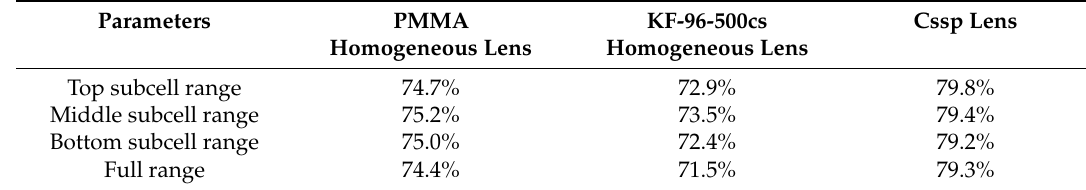
Figure 11. Simulated optical efficiency for varied focal lengths in comparison with different wavelength bandwidths corresponding to the top (blue), middle (green), bottom (red) subcell of the triple-junction solar cell, and the full solar spectrum at C = 100 × (black). ( a ) PMMA homogenous spherical lens, ( b ) KF-97-500cs homogeneous spherical lens, and ( c ) CSSP lens. Table 5. The maximum optical efficiency of the lenses corresponding to Figure 11. Parameters